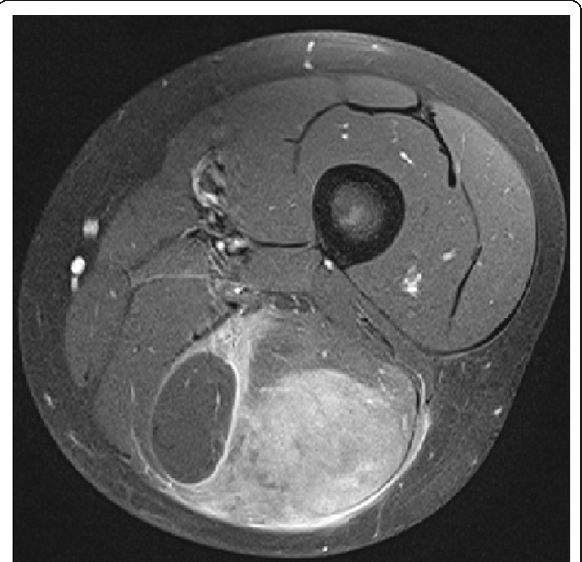
Figure 1 Axial MRI of the left thigh delineates an ill-defining tumor mass within the long head of the biceps femoris muscle with vivid uptake of contrast media while measuring 4 × 3 × 9 cm in size